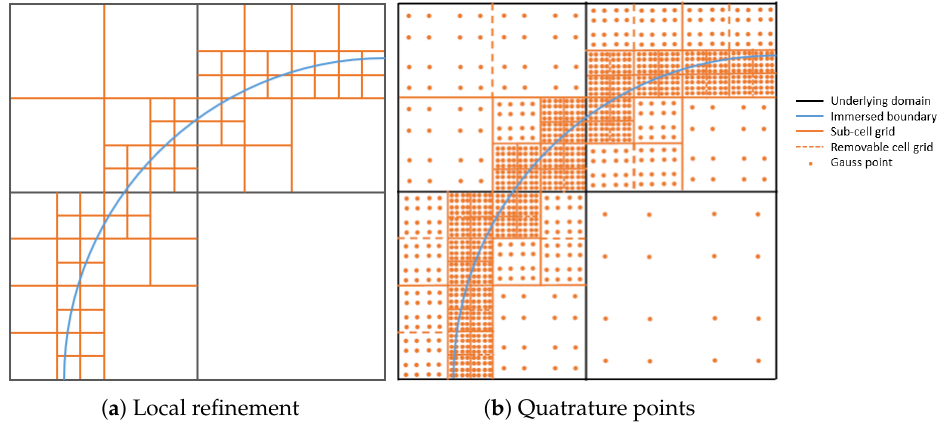
Figure 1. Illustration of ( a ) refinement of fields and ( b ) their associated quadrature points near immersed